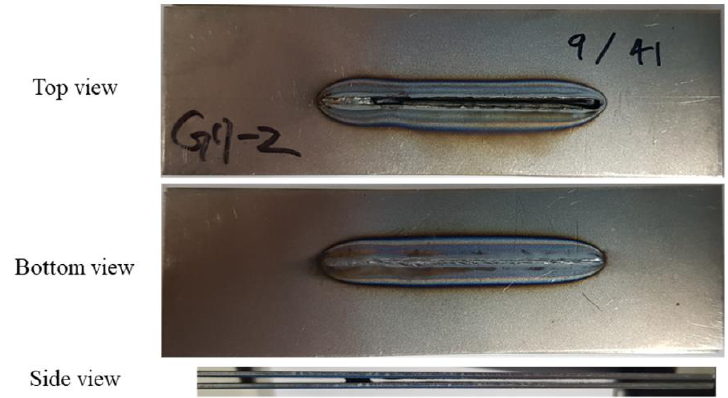
Figure 6. Workpiece appearance with a gap of 0.8 mm after welding with a welding speed 1.5 m / min and a laser power of 3000 W: top view, bottom view, side view .